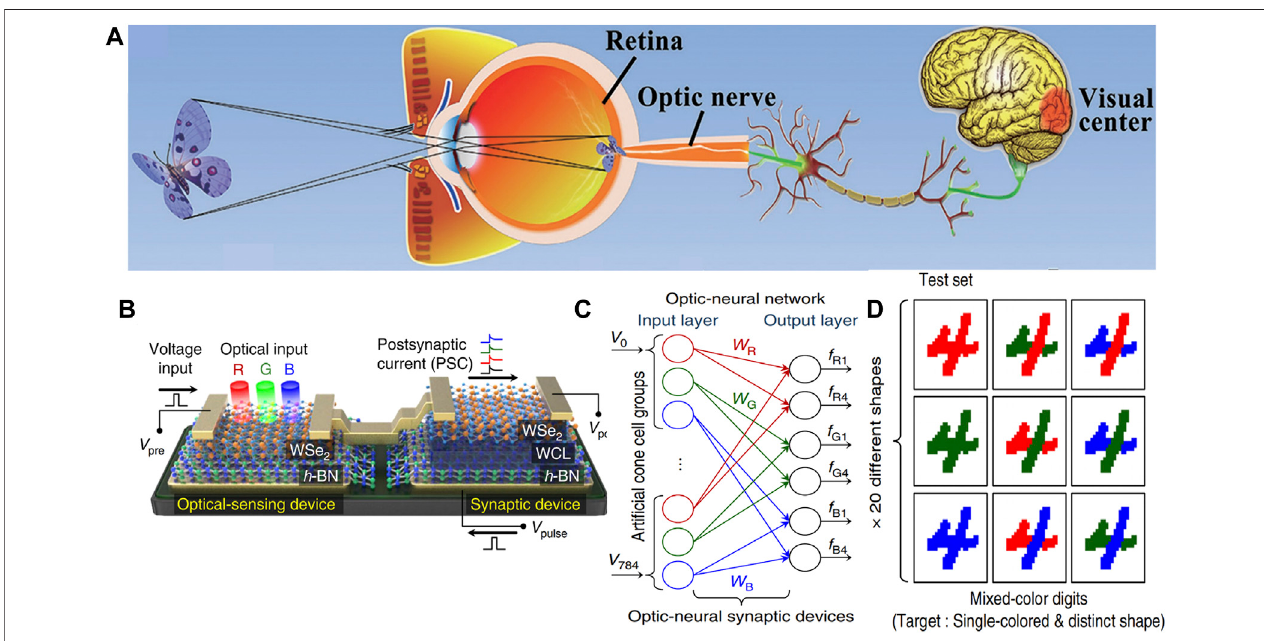
FIGURE2|(A) Schematicdiagramsofhumanvisualsystemwhenabutter fl ywasobservedbyeyes(adaptedfromChenetal.,2018). (B) Theh-BN/WSe device integrated with h-BN/WSe 2 photodetector. (C) Developed optic neural network forrecognition of28× 28RGB-colored images. (D) Examplesofthe training and the testing datasets consisting of single-colored and color-mixed numeric pattern images, respectively (adapted from Seo et al., 2018).